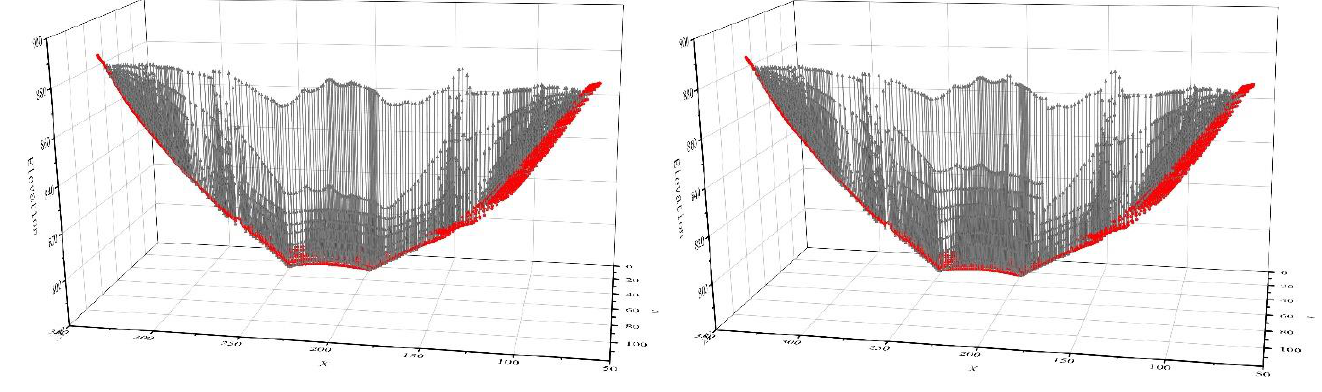
Figure 11. Distribution of design and measured uplift pressure.